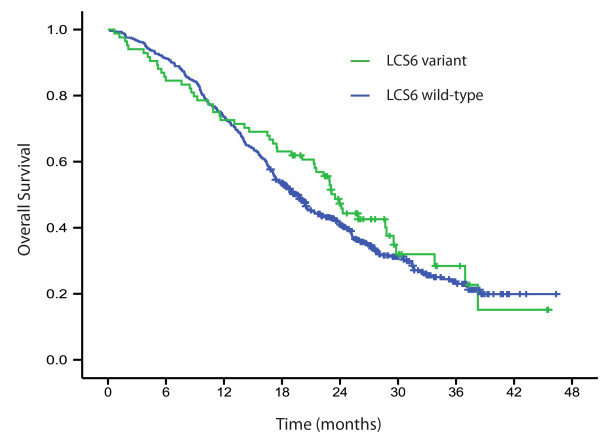
Kaplan-Meier overall survival by LCS6 wild-type (N= 451) and LCS6 variant (N= 84), log rankP= 0.31.